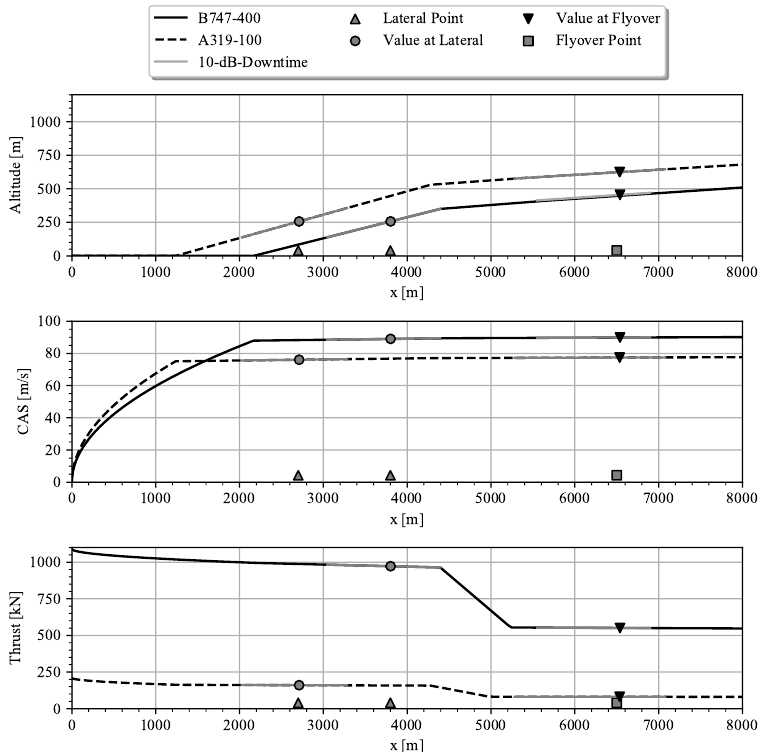
Figure 4. Departure Flightpath with lowest EPNL for virtual noise certification with flyover position and lateral reference meseaurement